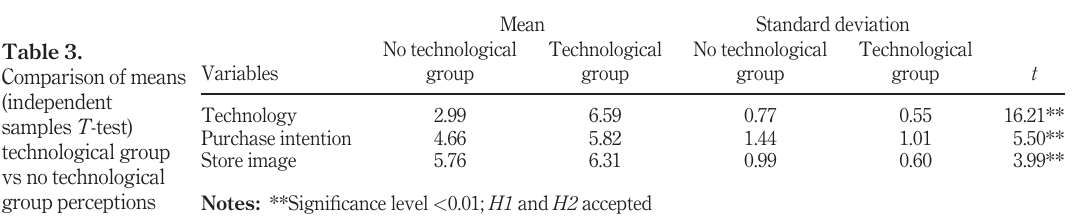
(independent samples T -test) technological